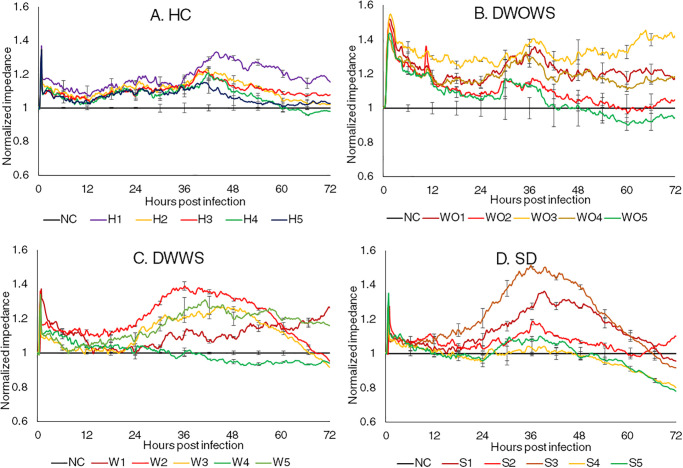
Normalized real time impedance changes in retinal MECs incubated with serum samples from the category of (A) Healthy individuals (HC), (B) dengue without warning signs (DWOWS), (C) dengue with warning signs (DWWS) and (D) severe dengue (SD). Five serum samples from each dengue category consisted of samples with high NS1 level (red lines), medium NS1 level (yellow lines) and low NS1 level (green lines). The error bars represent the standard error of mean between three biological triplicates for each sample.